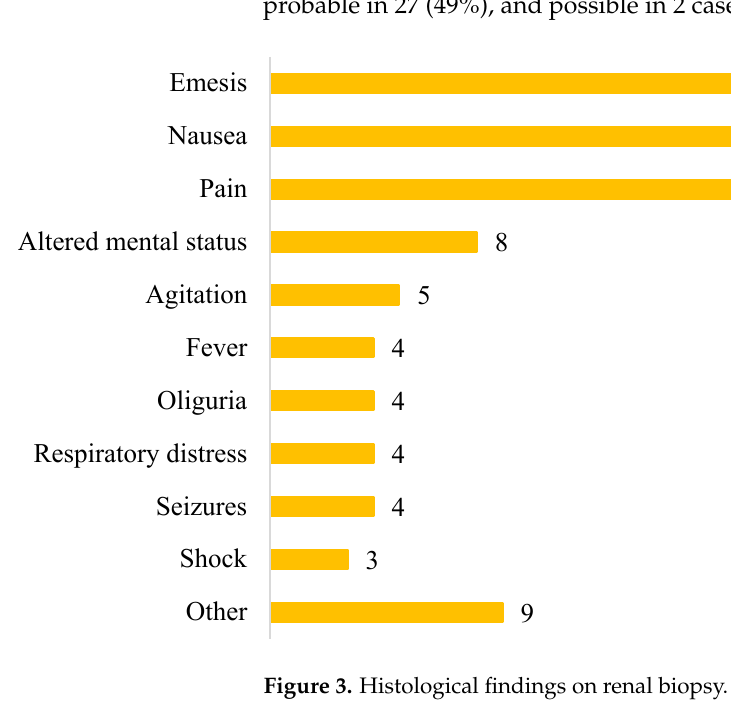
Figure 3. Histological findings on renal biopsy. Figure 3. Clinical presentation of synthetic cannabinoid intoxication.